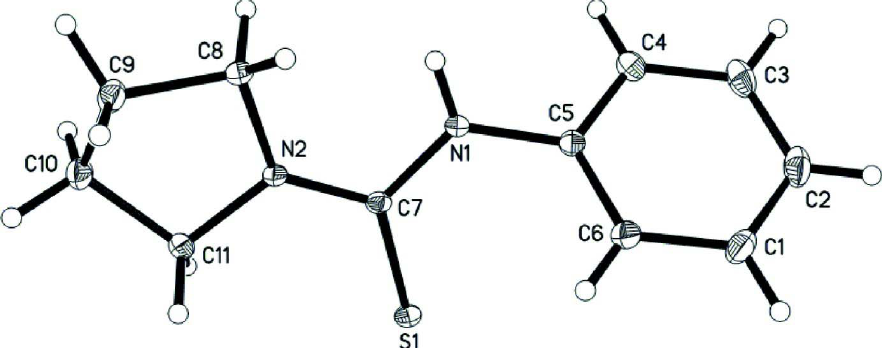
The structure of the title compound showing 30% probability displacement ellipsoids and the atom-numbering scheme. N -Phenylpyrrolidine-1-carbothioamide Crystal